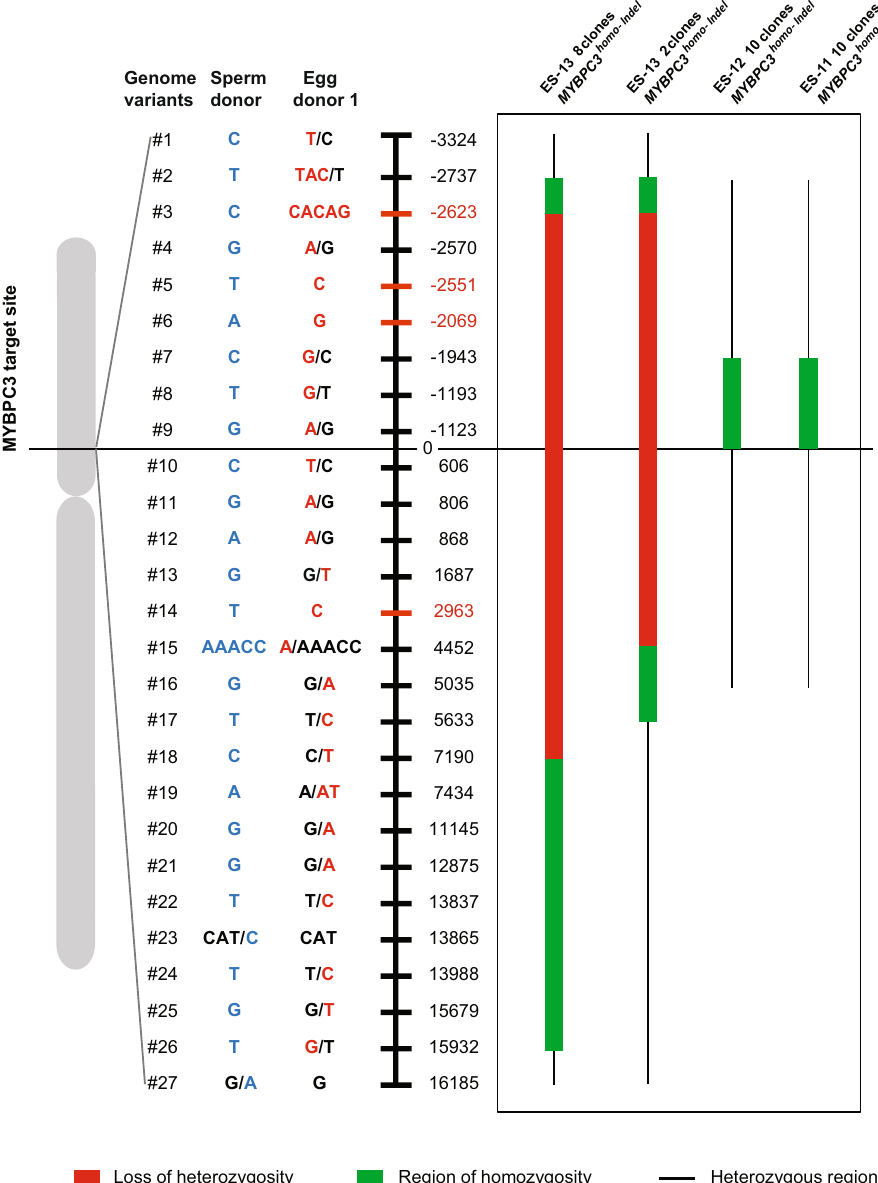
MYBPC3 Indel/Indel genotype from same egg and sperm donors. LOH and direction of conversion tract in each clone is indicated in color lines. Red lines indicate that theselocilostpaternalnucleotidesandbecomehomozygousmaternal.Greenlines indicatethattheselociarehomozygousbutLOHcannotbedeterminedbecauseof initial heterozygosity in contributing gametes. Black lines indicate that these loci are heterozygous. Source Data are provided as Supplementary Data